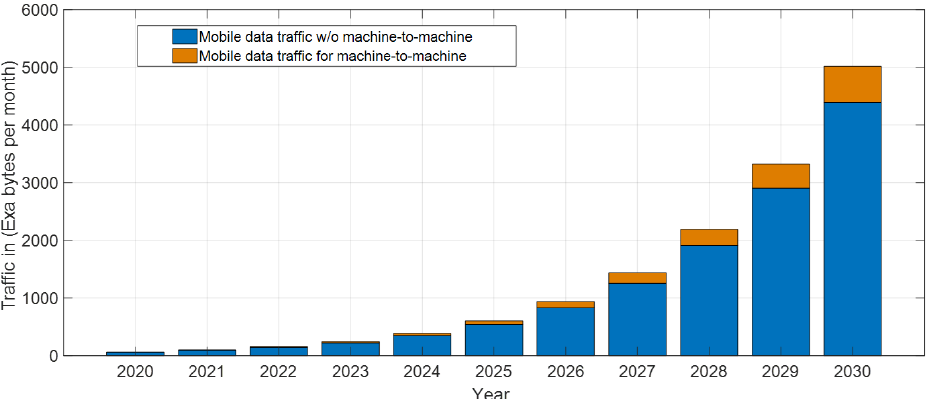
Figure 1. Global mobile data traffic forecast for the period 2020 to 2030 (ITU)